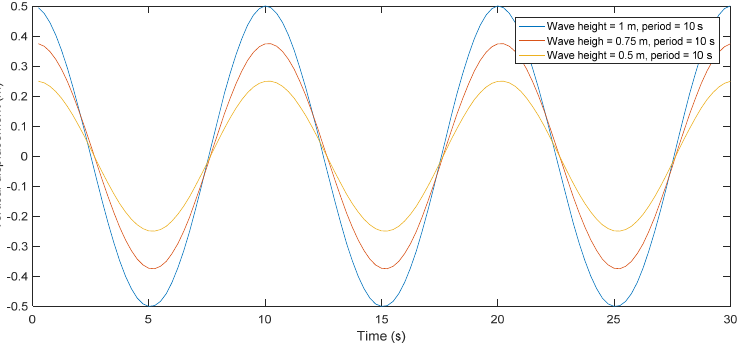
Figure 5. Vertical displacement of the upstream collar under waves with different heights.